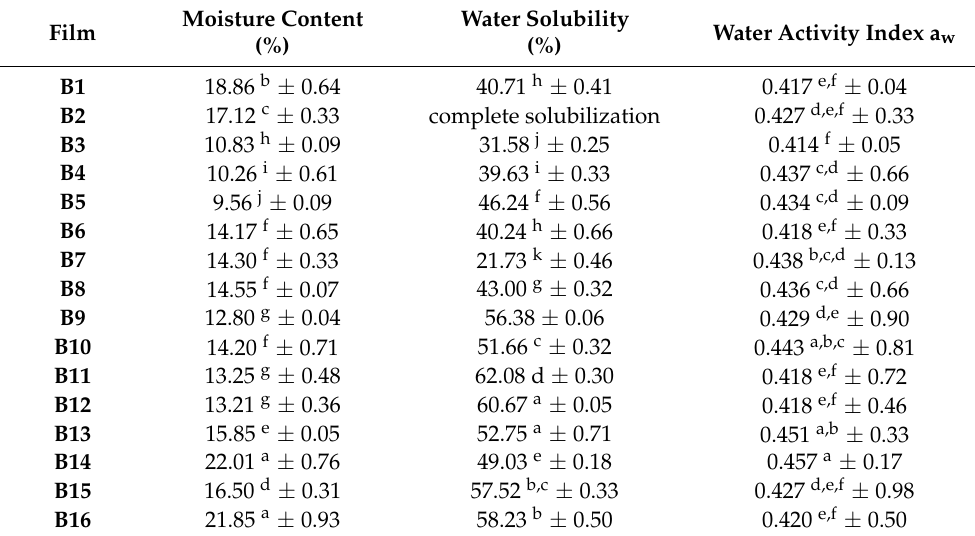
Table 4. Characteristics of the films.